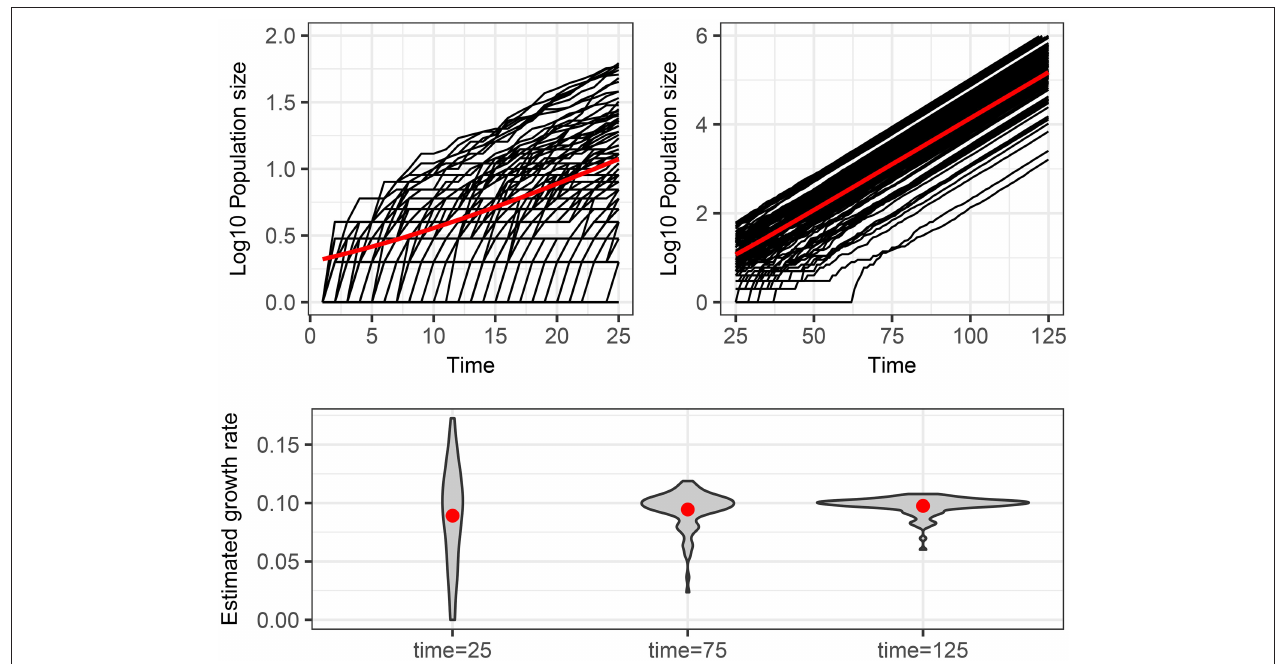
FIGURE 1 | Stochastic realizations of a pure birth process and distributions of deterministic estimation of the growth rate at different times. Top figures show 100 trajectories from a continuous time pure-birthh process with parameter α = 0.1 over two time scales. The only difference between each trajectory is intrinsic stochastic variability. The red line shows the expected population size assuming a deterministic process, which is also the mean number of infected of the stochastic process if there is no parametric variability. The bottom plot shows the distribution of estimated growth rates obtained by fitting a linear model to the log 10 of the population size for each of the 100 trajectories from time 0 to times 25, 75, and 125. The red dots indicate the mean of the estimated growth rates, which are all close to the true value of